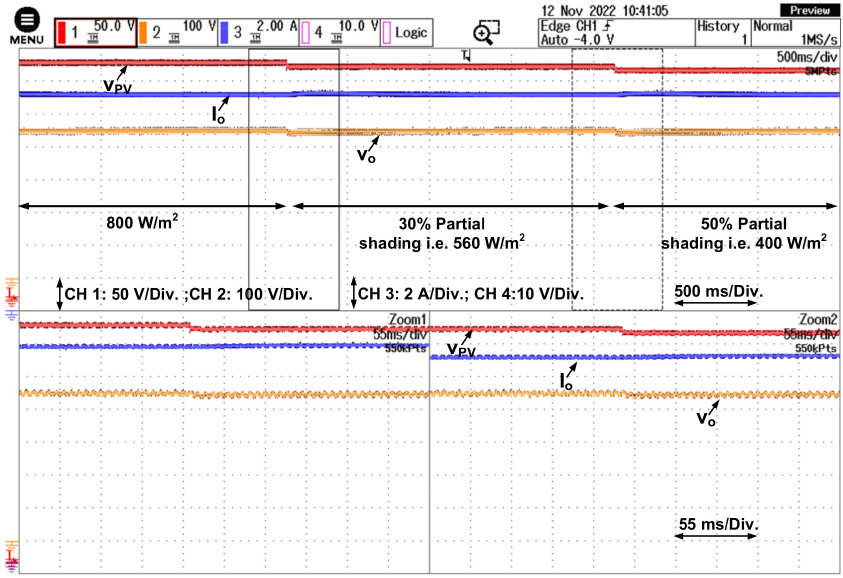
Figure 24. Experimental waveforms under partial shading of V PV , V O , and I O curves.